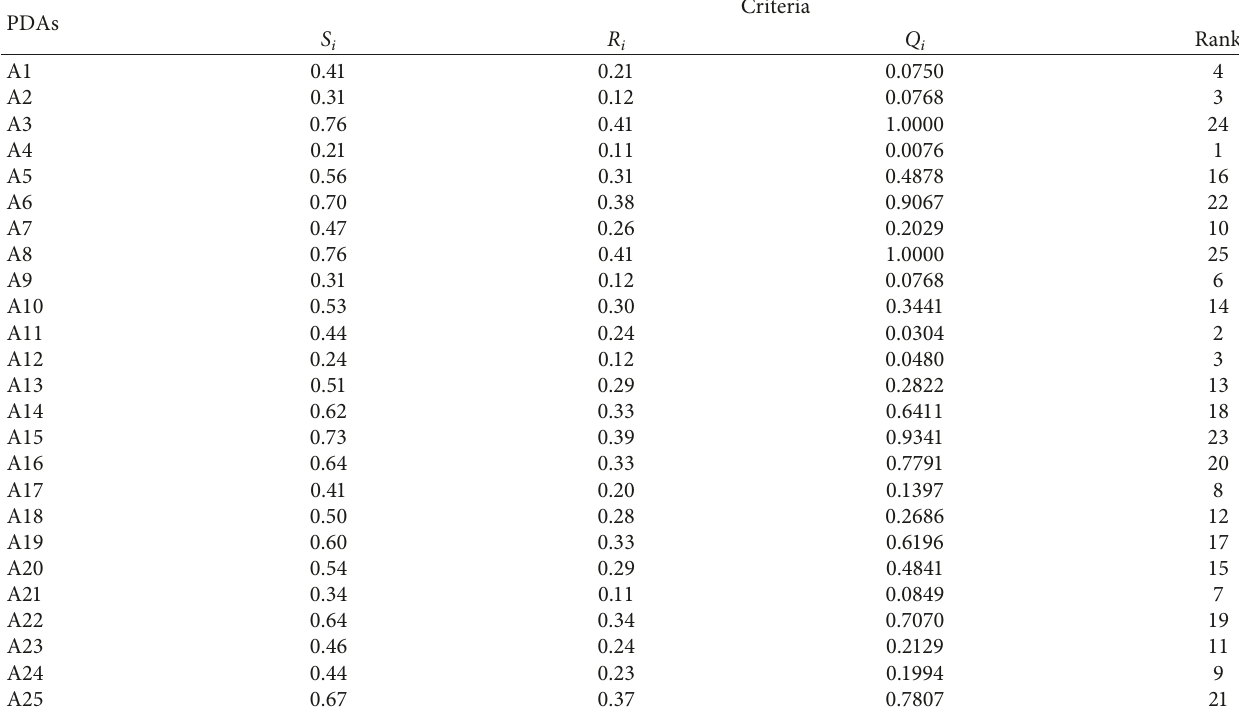
Table 14: S i , R i , and Q i values and ranking of alternatives using